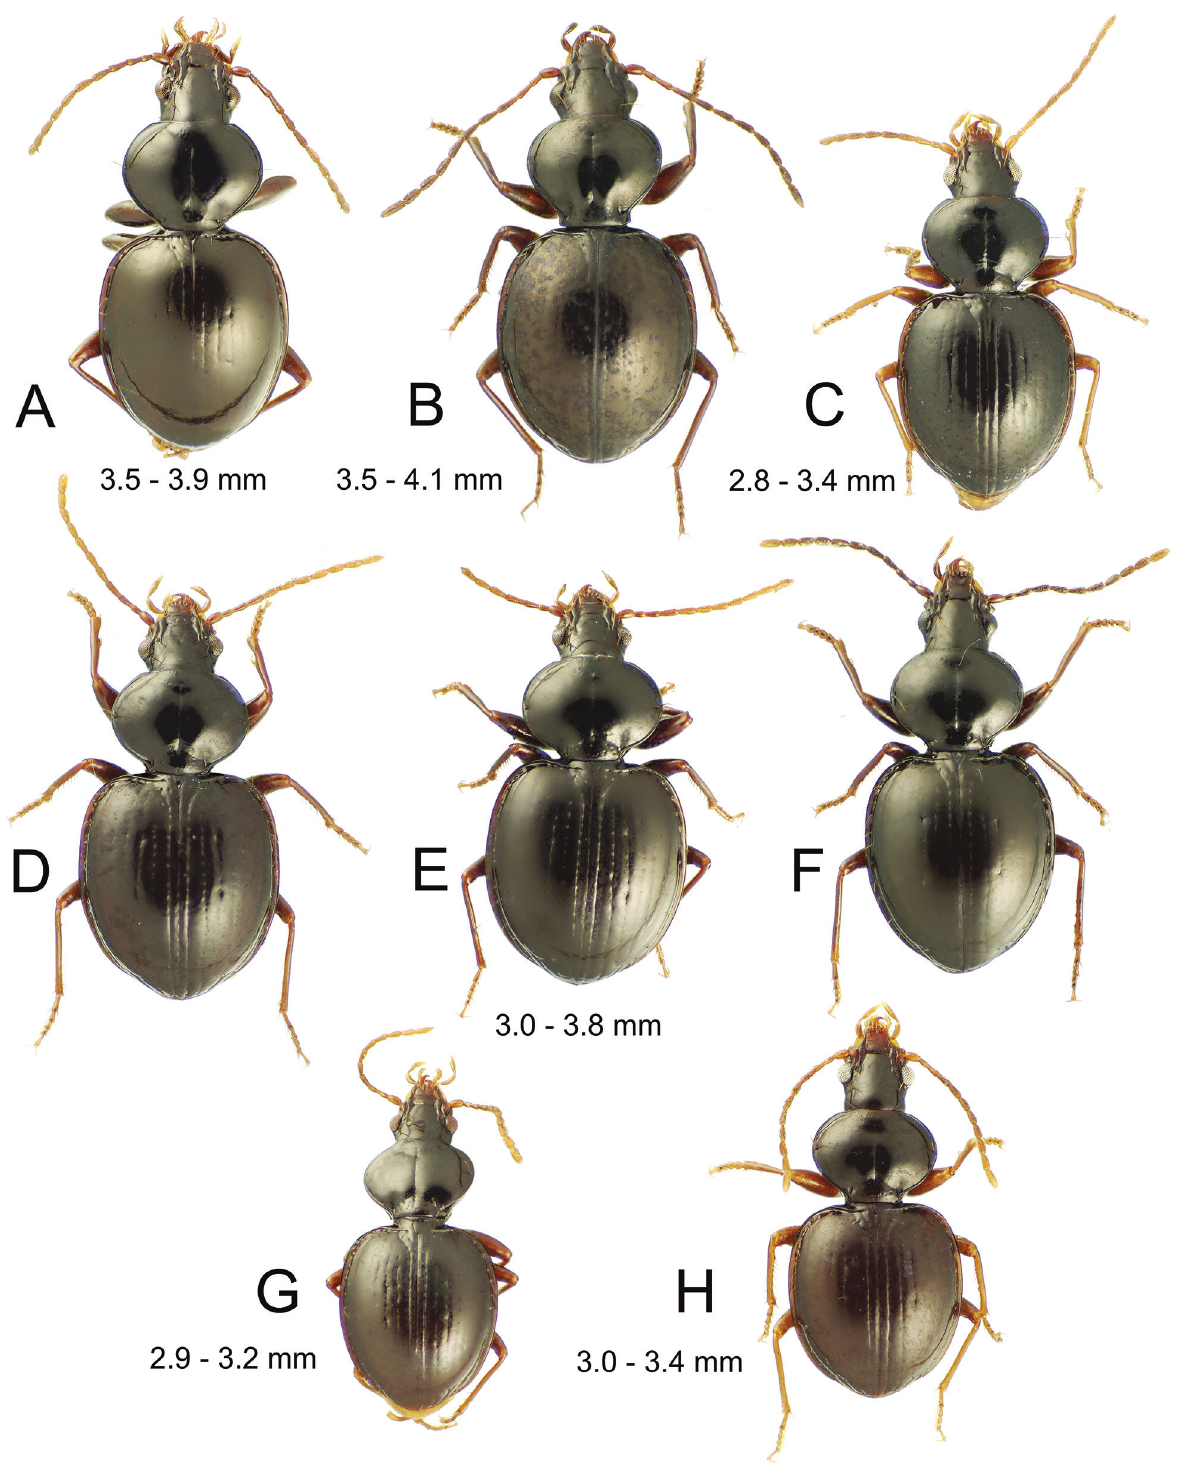
Figure 20. New Caledonian Mecyclothorax ( Phacothorax ) spp., dorsal view: A , M. manautei ; B , M. paniensis ; C , M. mouensis ; D , M. kanak (Mt. Humboldt, 580 m); E , M. kanak (Mt. Humboldt, 630 m); F , M. kanak (Mt. Dzumac); G , M. kanak (Col de Yaté); H , M. picdupinsensis